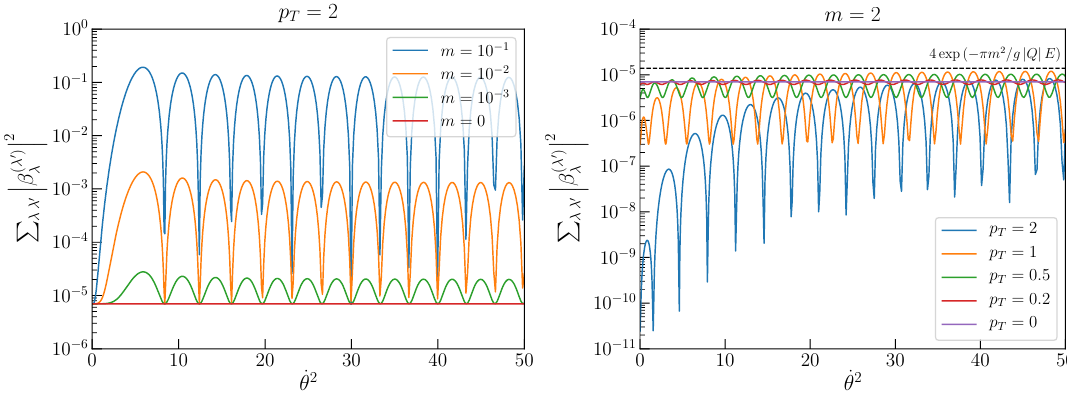
0 ) | β ( λ | 2 evaluated at p z = − 50 as λλ 0 λ